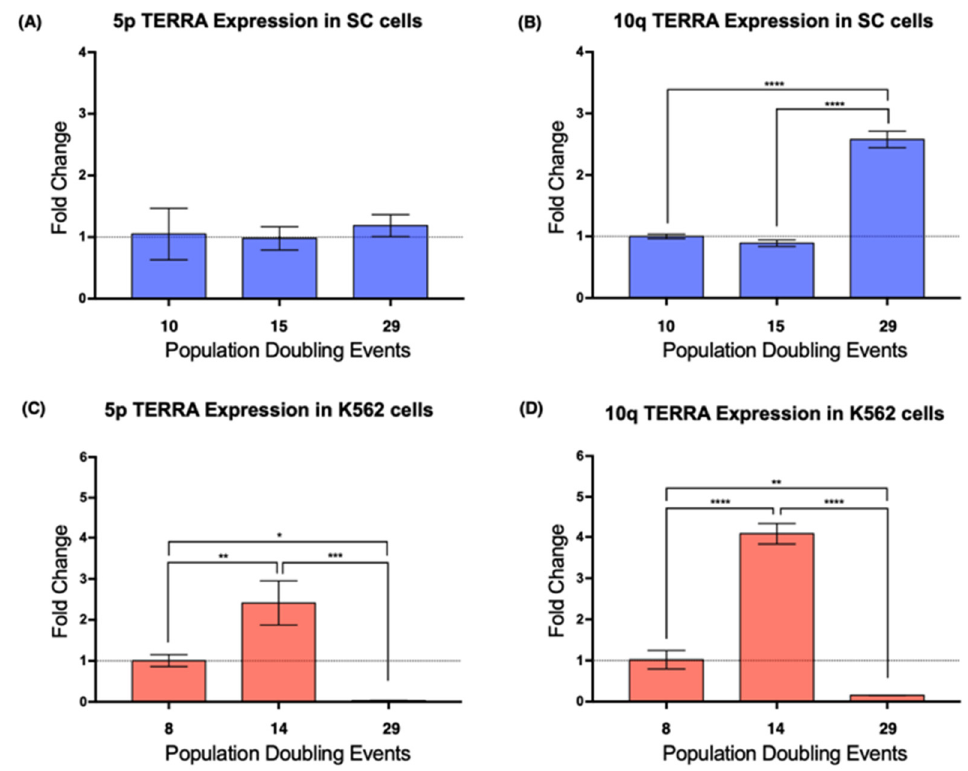
Figure 4. The expression of TERRA changed in a telomere-specific manner. ( A ) The expression of TERRA 5p was unaffected by cellular aging in SC cells. ( B ) Expression of TERRA 10q increased significantly after 29 PDs of the SC cells. ( C , D ) There was a similar expression pattern in both loci of the K562 cells. TERRA expression increased after 14 PDs and then dropped significantly after 29 PDs. Data were analyzed using ANOVA and Tukey’s multiple comparisons test. Adjusted p value < 0.0001 (****), =0.0003 (***), <0.005 (**), = 0.0240 (*).